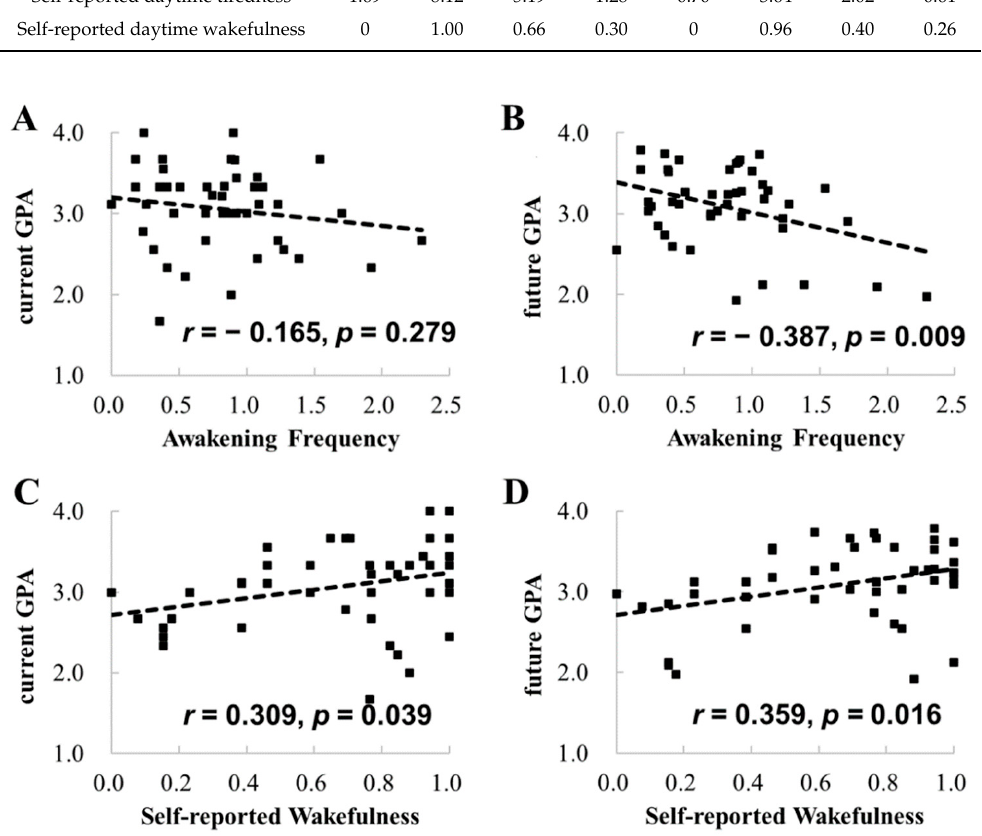
Figure 1. Correlations between awakening frequency and the current and future GPAs ( A , B ), and correlations between self-reported wakefulness and the current and future GPAs ( C , D